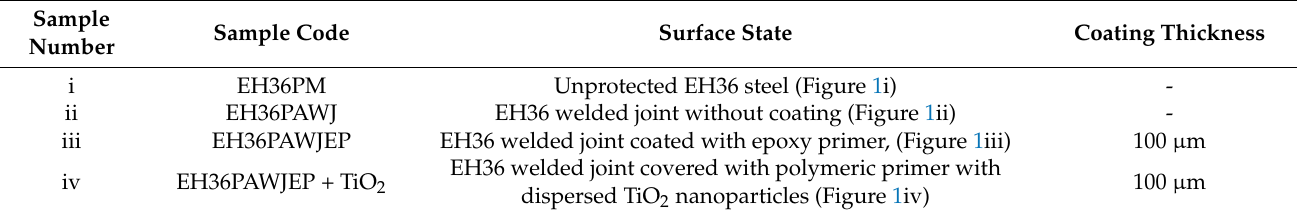
Table 1. Samples used for corrosion resistance